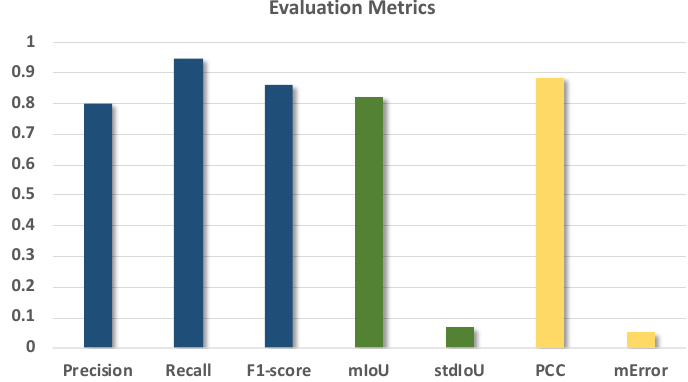
Figure 11. Quantitative evaluation results on seven